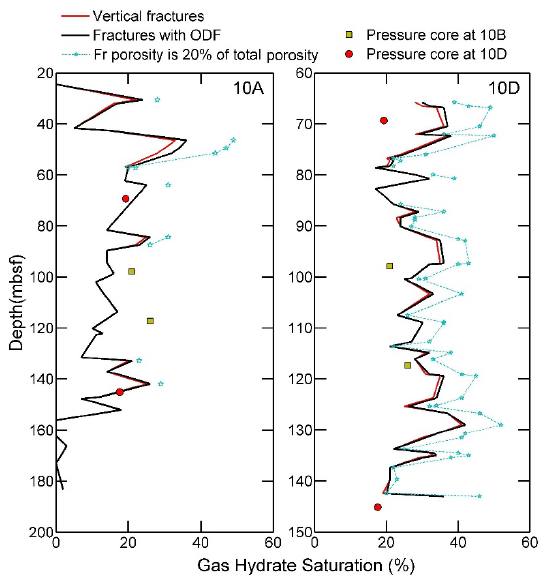
Figure 5. Gas hydrate saturation varying with depth is depicted for well 10A and 10D. Red (light line) represents grain displacing morphology if fractures are vertical. Black (dark line) represents saturation variation with depth for fractures oriented and smoothed according to ODF. Dotted and/or star represents hydrate saturation for combined approach of pore filling and grain displacing if fractures porosity contribute to 20% to the total porosity.